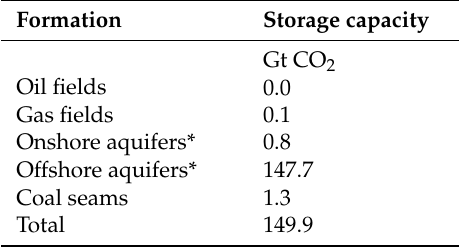
Table 1. Overview of existing effective storage capacity estimates for South Africa [29].